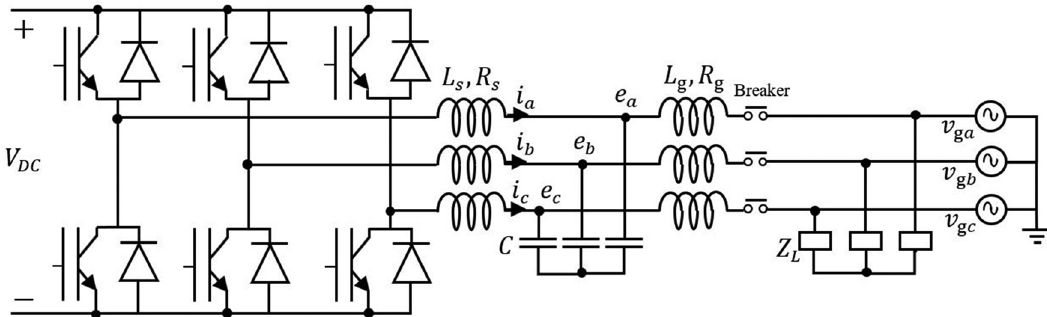
Figure 1: Synchronverter connected to a local load Z L and the power